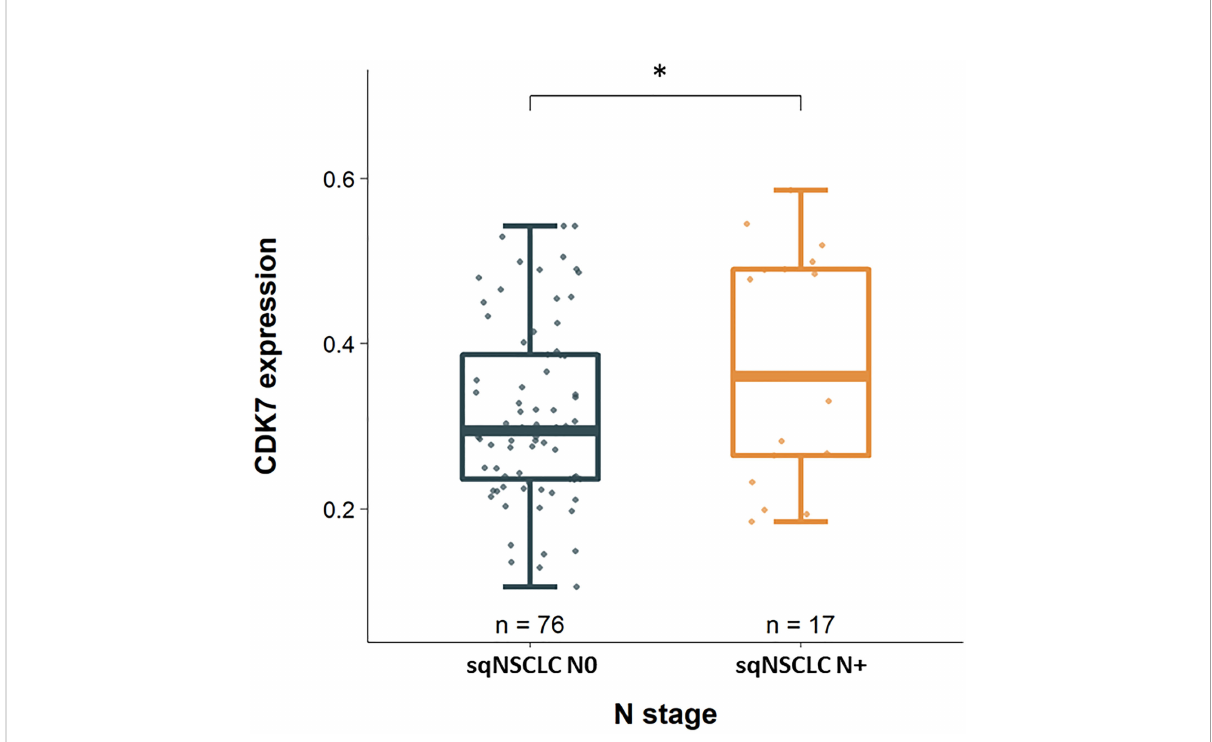
FIGURE 3 CDK7 expression between sqNSCLC with and without lymph node metastases. Compared to sqNSCLC with a pN0 stage, sqNSCLC with lymph node metastases show a signi fi cant higher CDK7 expression (* p